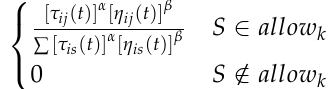
Figure 16. Attribution of solder joints in the intersection part.